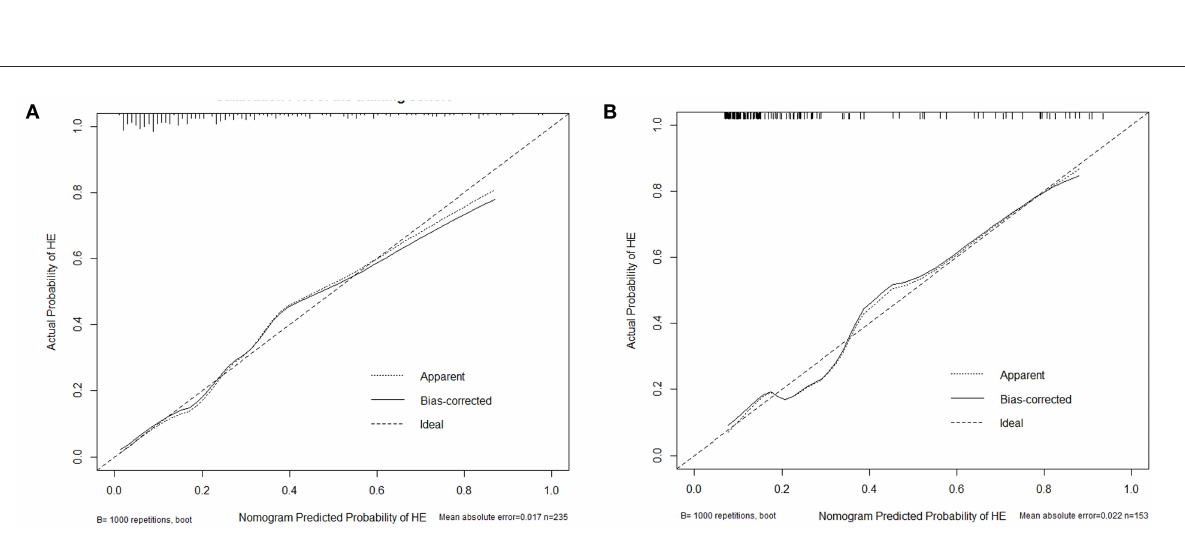
FIGURE6 Calibration plot of the nomogram in the training (A) and test cohort (B) . The dotted line represents the performance of the nomogram, whereas the solid line corrects for any bias in the nomogram. The dashed line represents the reference line where an ideal nomogram would